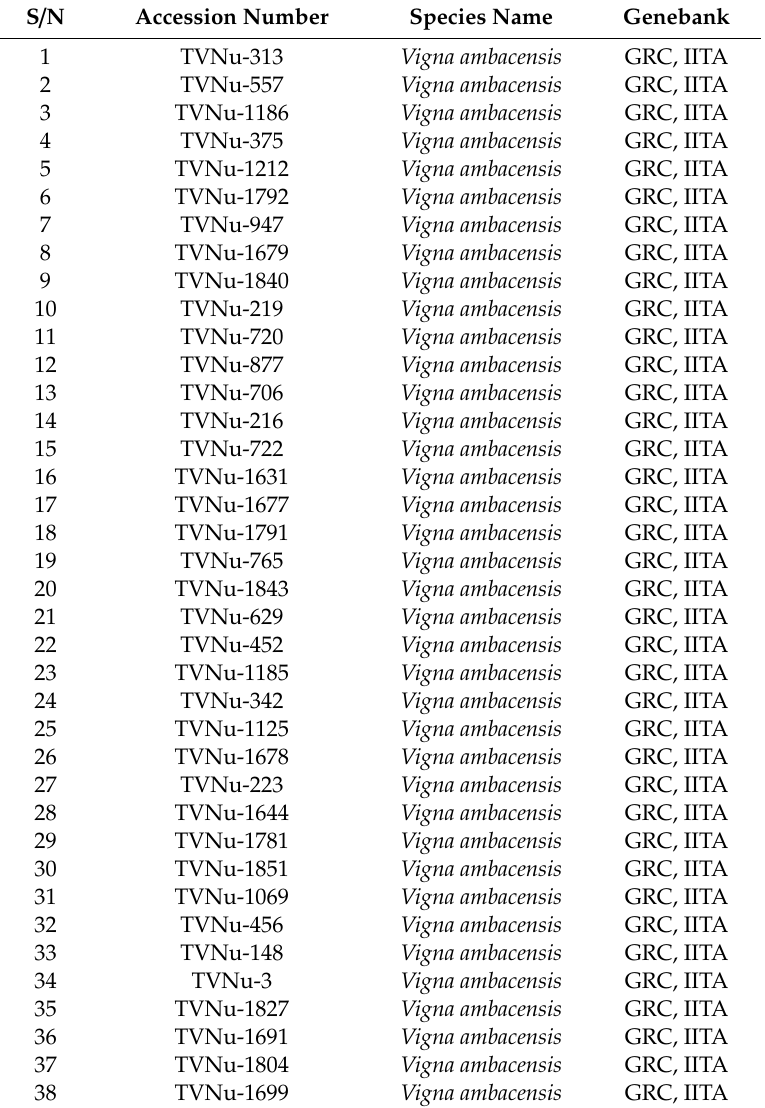
Table A1. Wild Vigna legumes accessions used in the